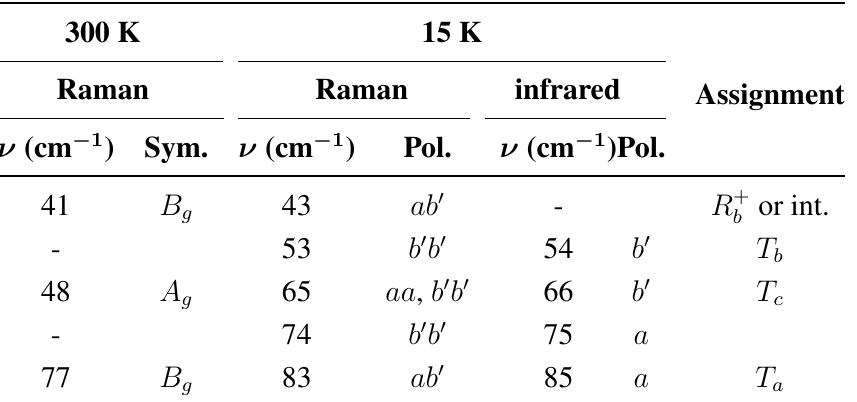
Table 6. Experimental frequencies and assignments of the (TMTTF) obtained from our Raman and infrared measurements at room temperature and T ≈ 15